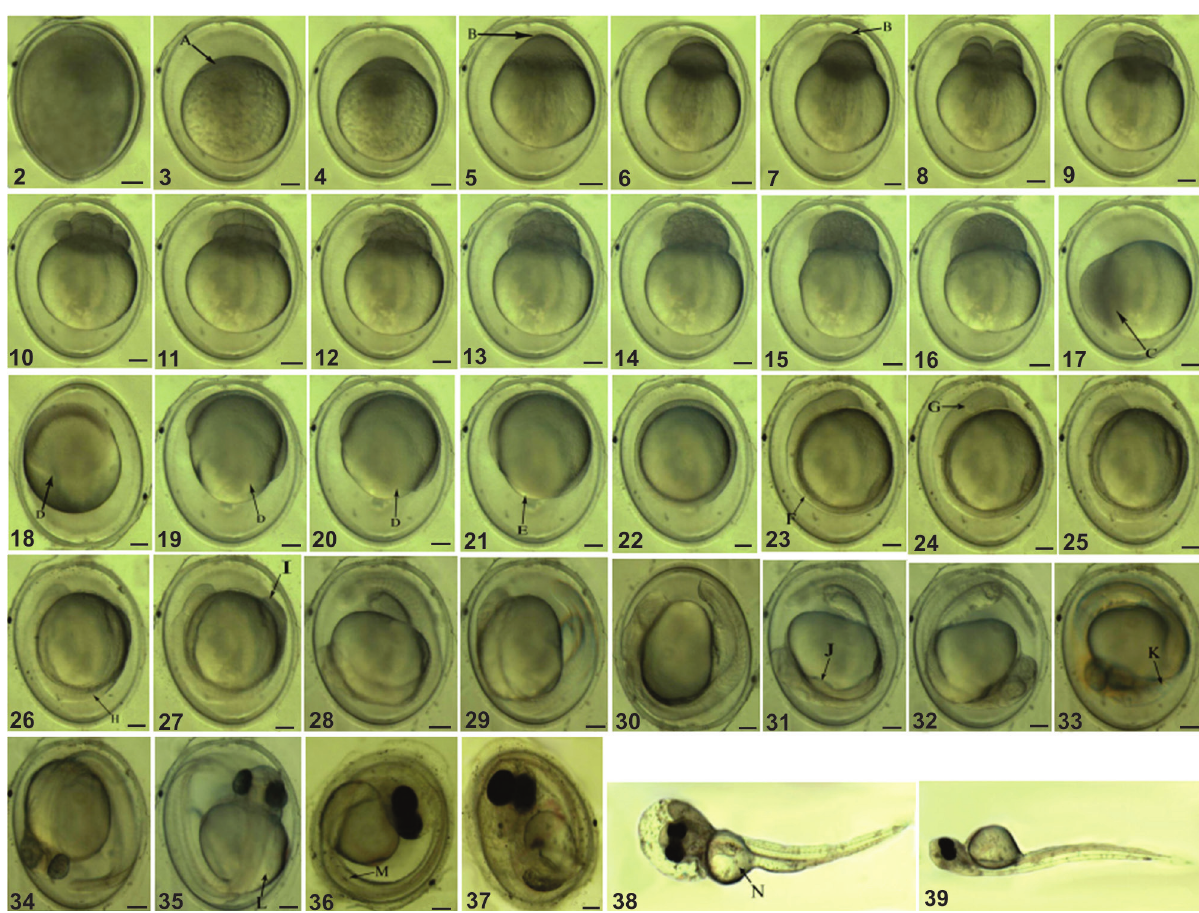
Figures 2–39. Embryonic development of Pseudorasbora parva : (2) Fertilized egg; (3) The fully-swollen egg (A, blastoderm); (4) Blasto- disc formation; (5) The first cleavage furrow (B, cleavage furrow); (6) 2-cell phase; (7) The second cleavage furrow (B, cleavage